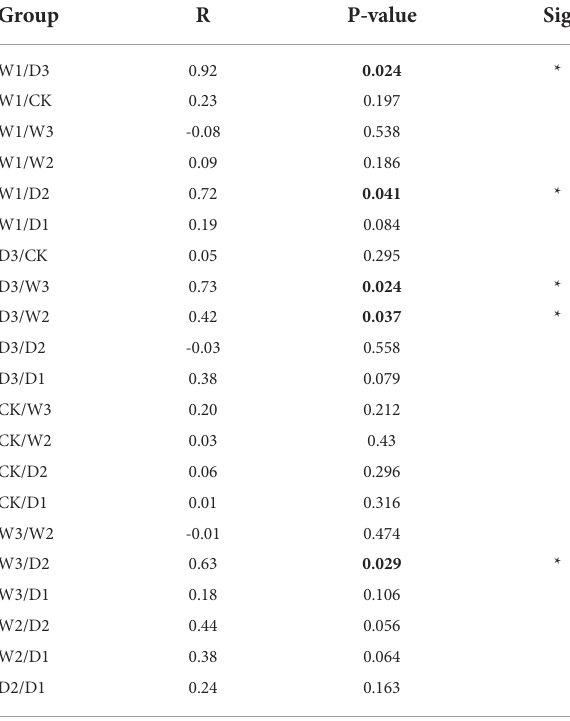
TABLE 3 Analysis of similarities (ANOSIM) of soil bacteria in alpine steppe on the Northern Tibet.